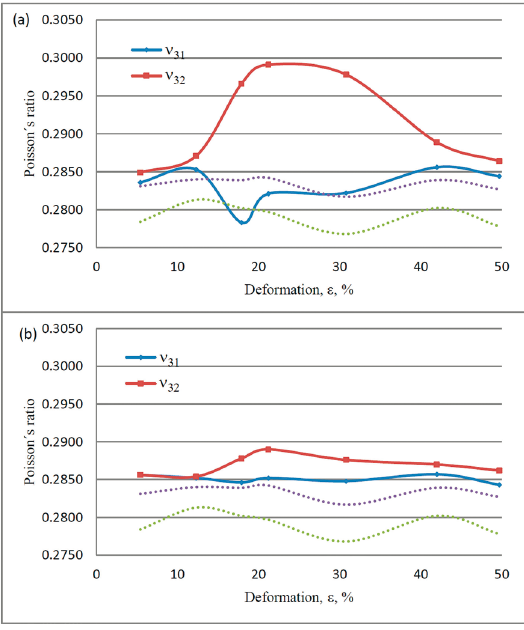
and ν in 31 32 31